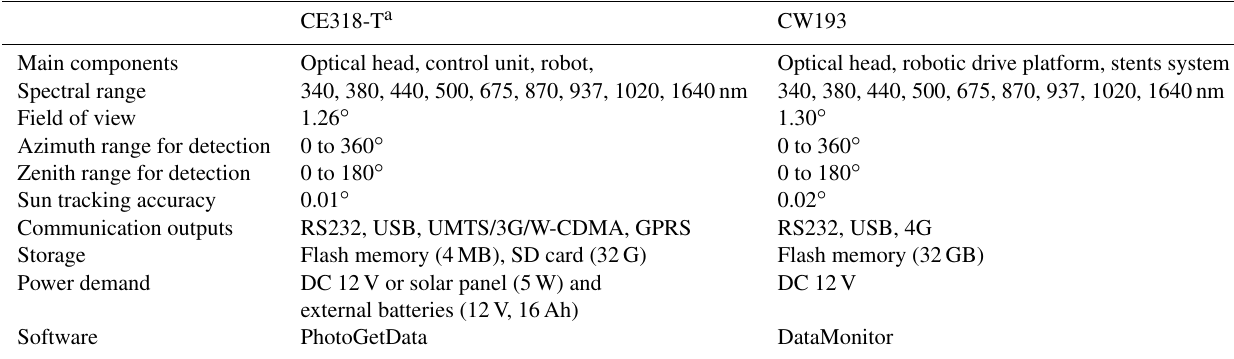
Table 1. Technical specifications for CE318-T a and